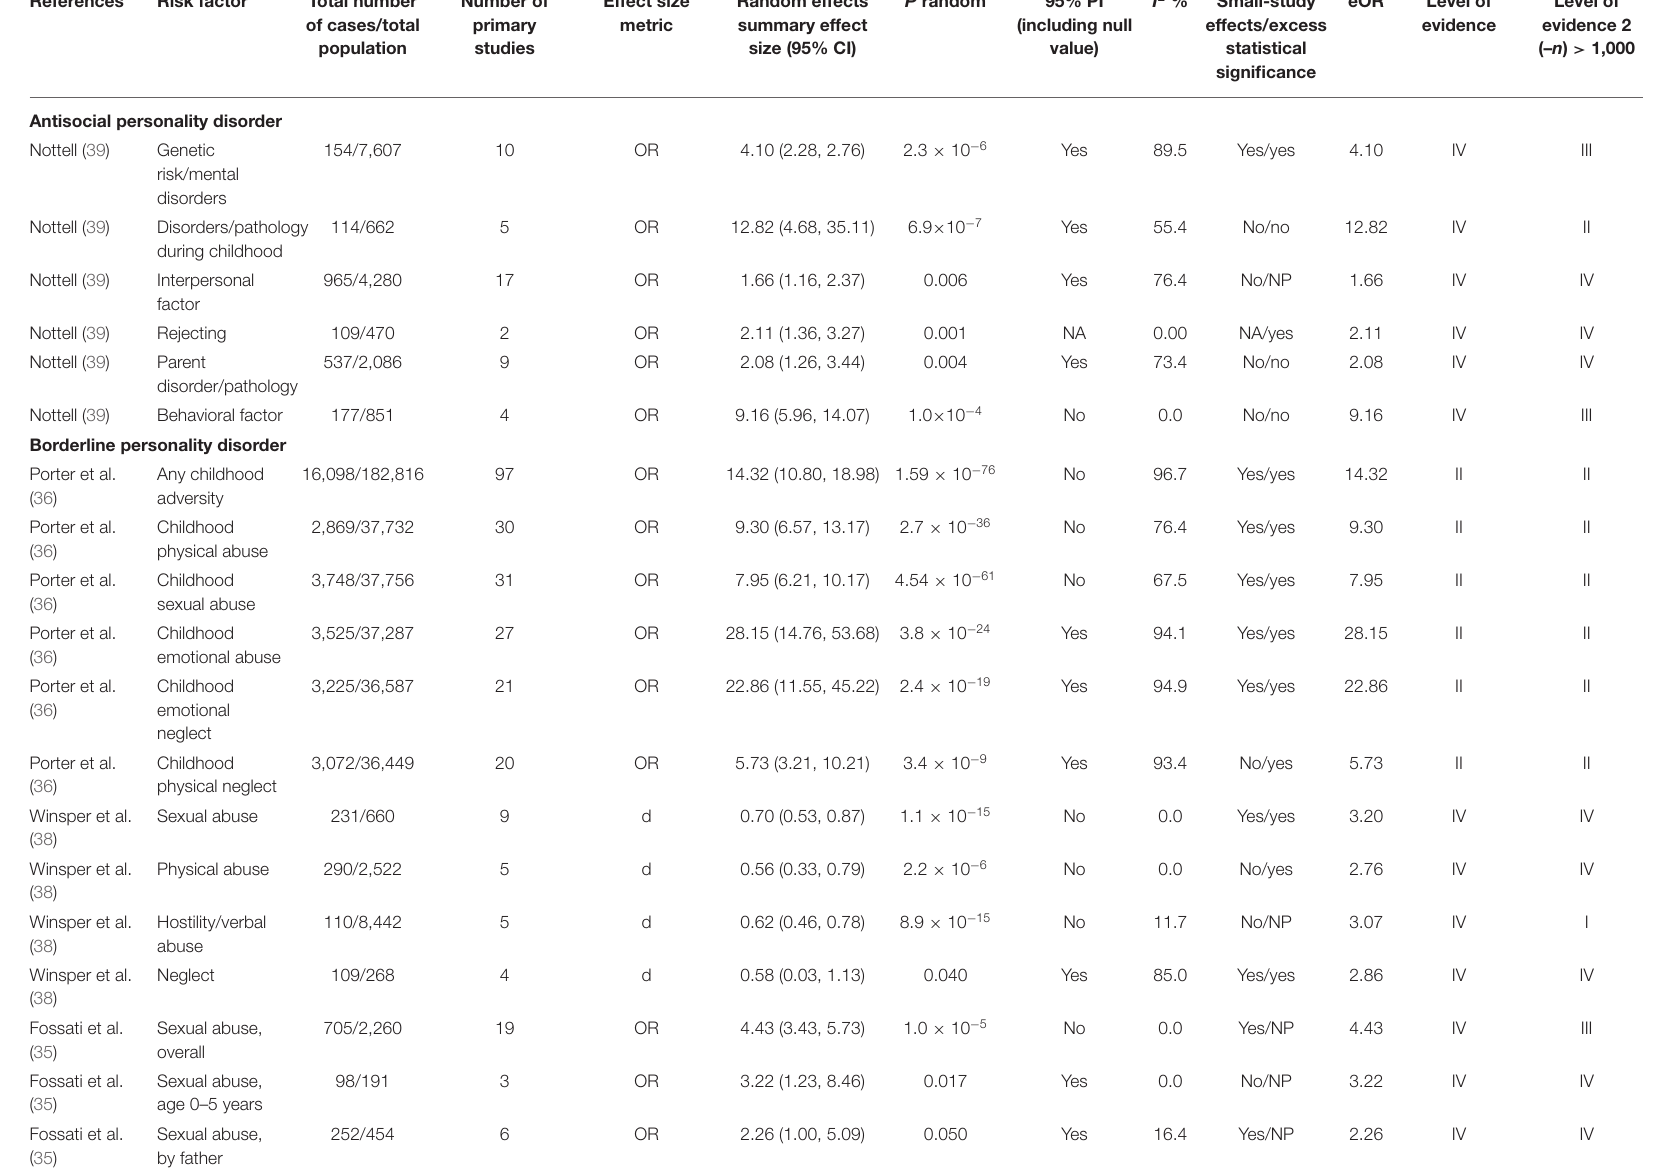
TABLE 3 | Potential significant environmental risk/protective factors of personality